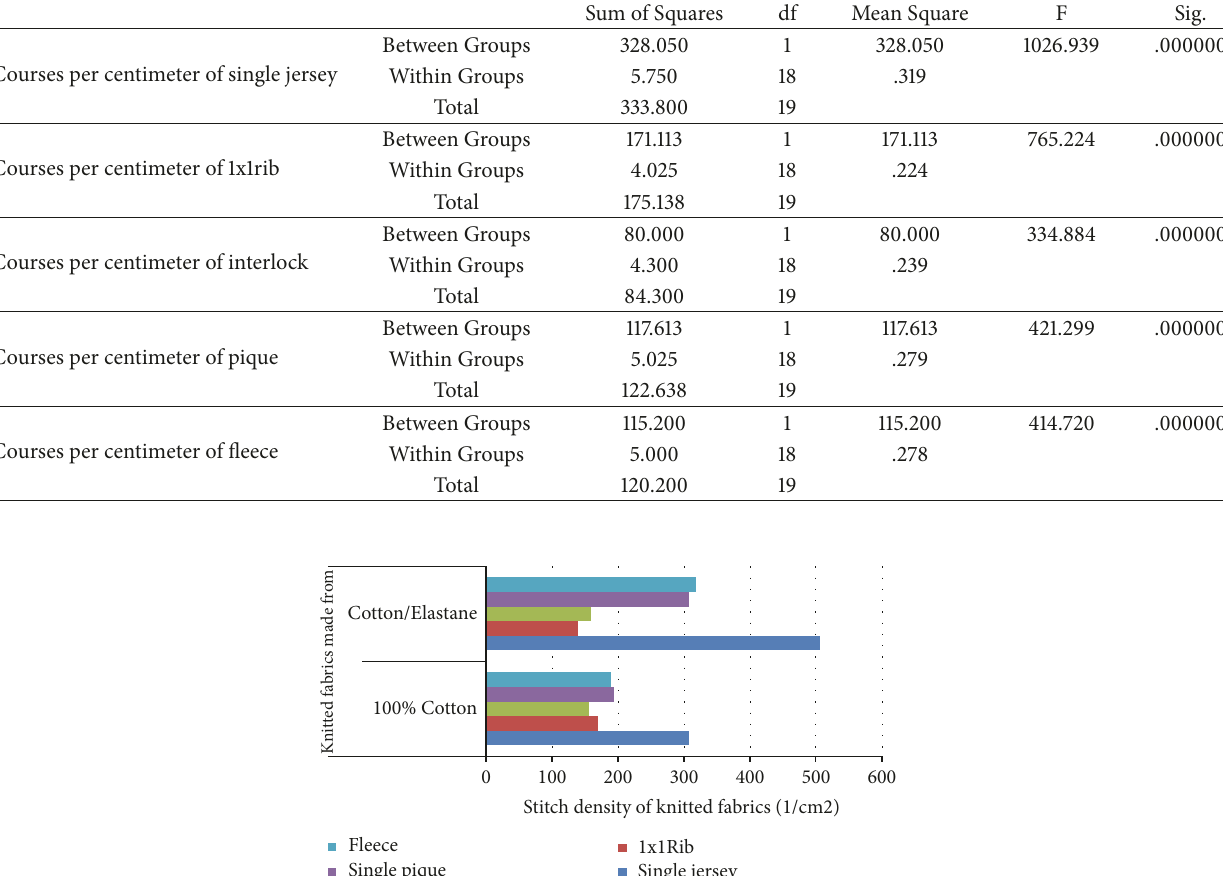
Table 6: Analysis of variances of knitted fabrics cpc made from 100% cotton and cotton/elastane yarns.